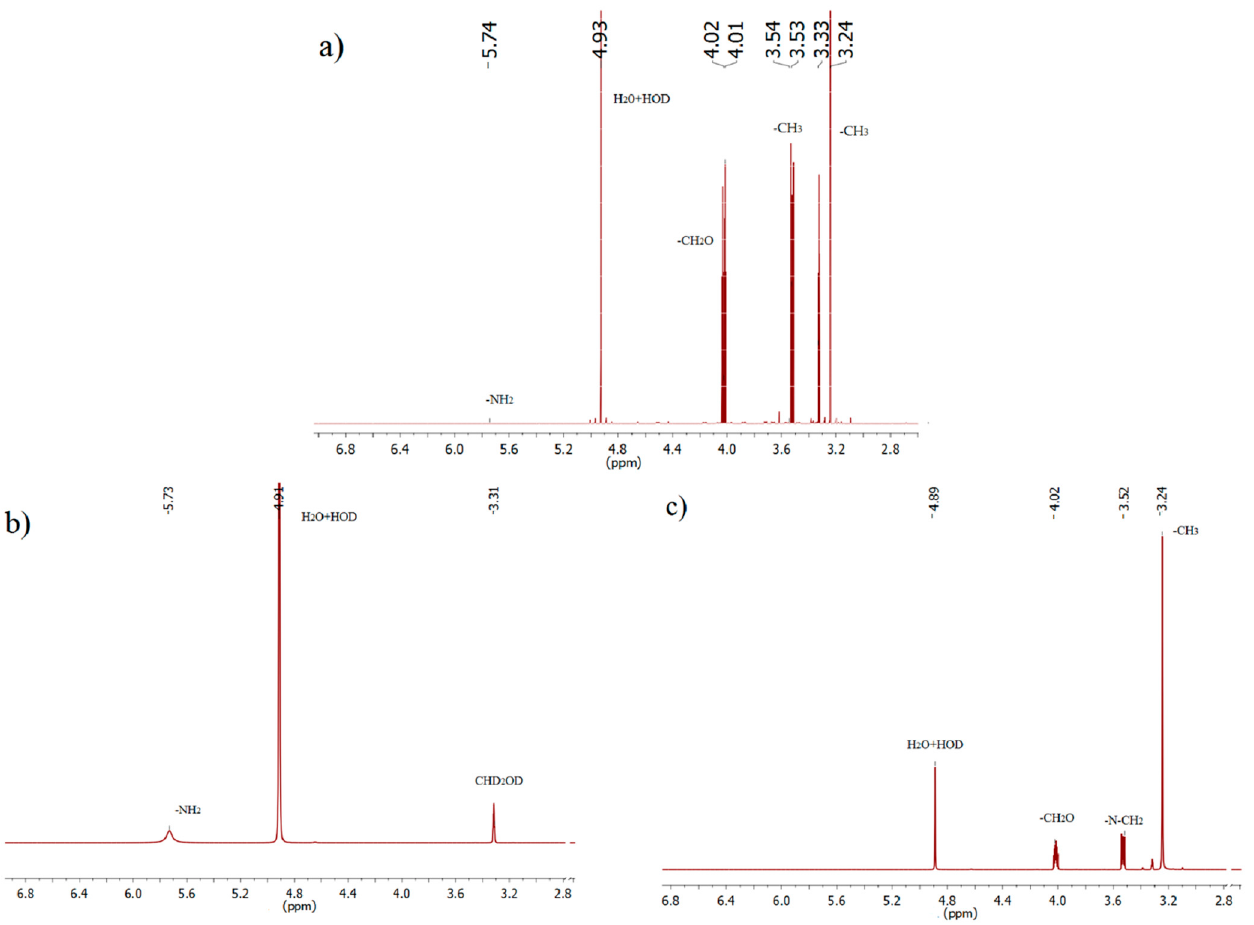
Figure 7. 1 H NMR spectra (500 MHz, methanol-d4) of ( a ) NADES (choline chloride/urea), ( b ) urea, and ( c ) choline chloride.